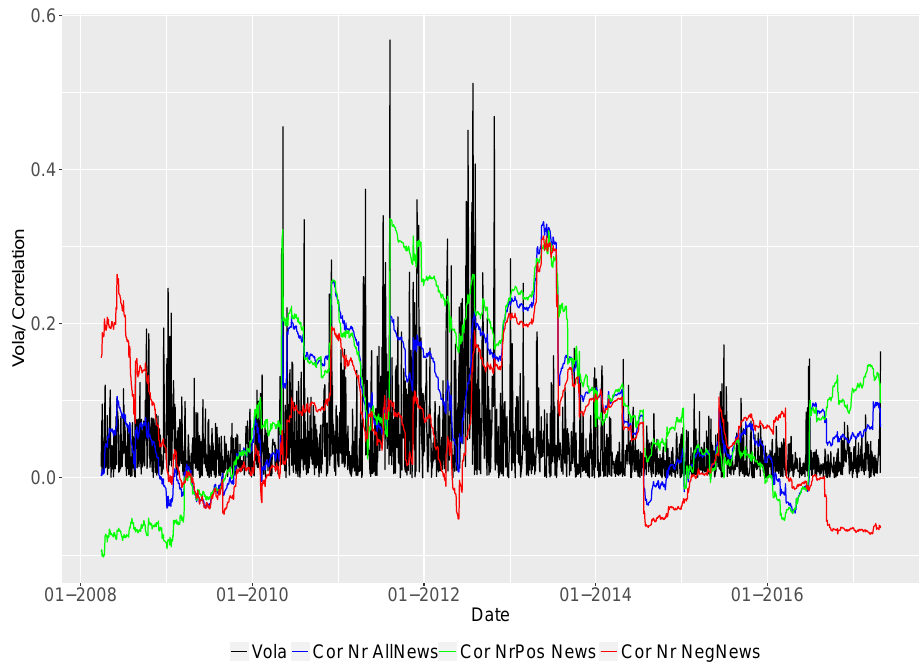
Figure 6. Rolling correlation between Spain bond volatility proxy and news volume time